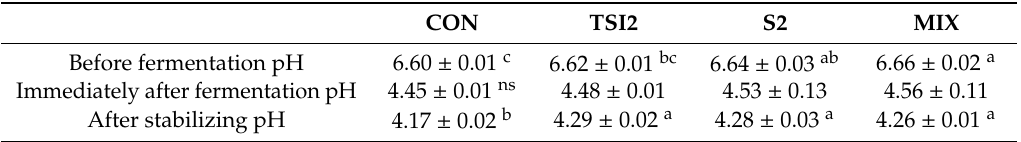
Table 3. The change of pH of each starter.